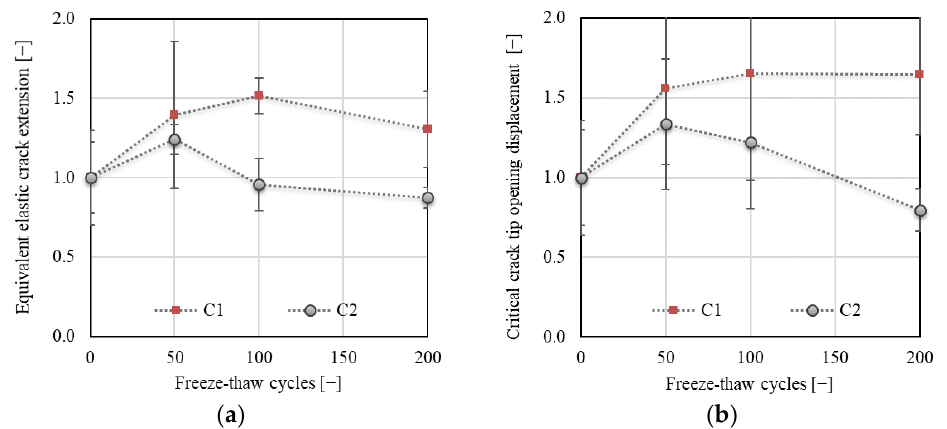
Figure 15. ( a ) Equivalent elastic crack extension; ( b ) critical crack-tip opening displacement (CTOD).